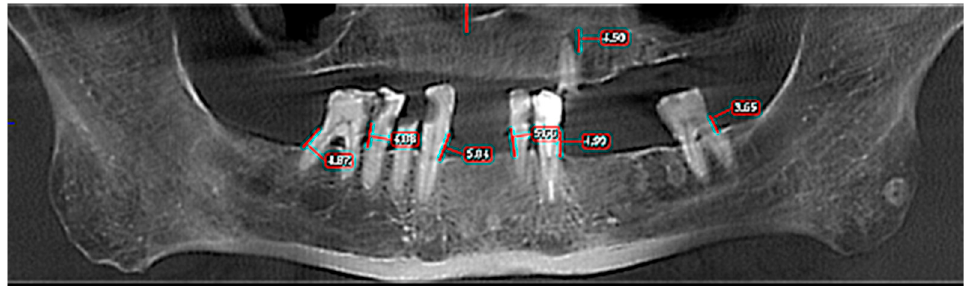
Figure 3. OPT–CBCT of Patient A.D., assessment of horizontal bone loss (maximum 6.8 mm at tooth 46) and measurement of the size of periapical lesions present at 23 is 4.5 mm.